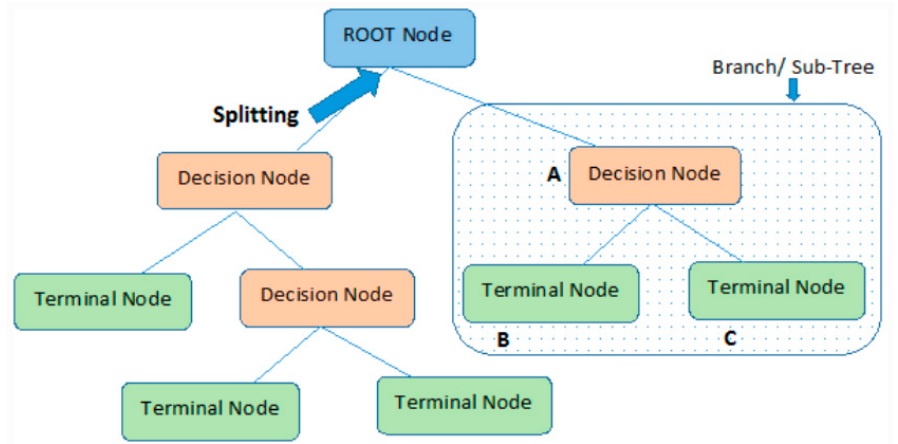
Figure 7. Decision tree schematic representation.